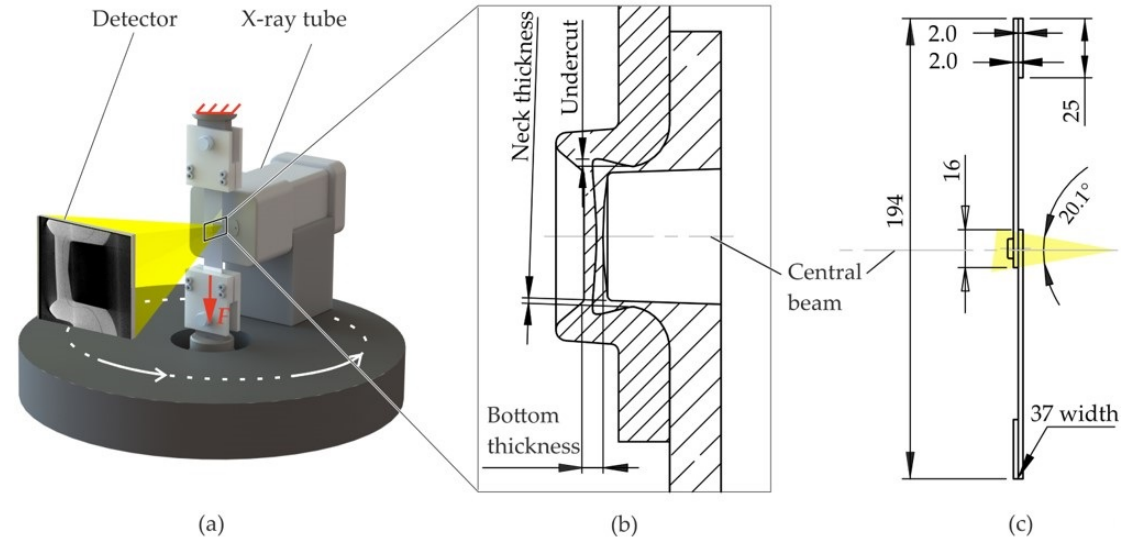
Figure 1. Schematic test set-up in the in situ computed tomography (CT) ( a ), the cross-section of the lap shear specimen in the initial position with the characteristic dimensions ( b ) and the overall specimen dimensions (in mm) ( c